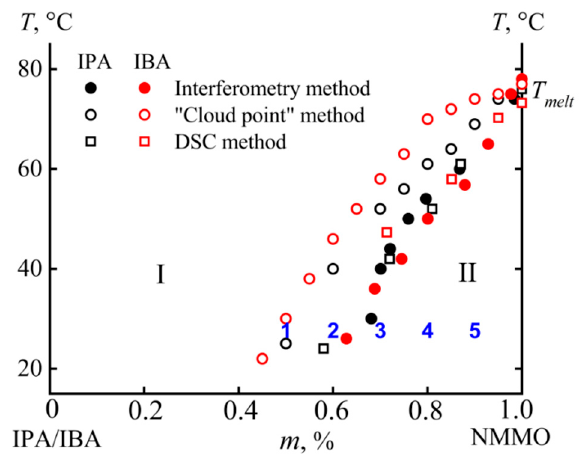
Figure 7. Phase diagram for the NMMO–alcohol system: (I) compatibility area; and (II) phase separation area. The numbers in the diagram correspond to the samples shown in Figure 3.